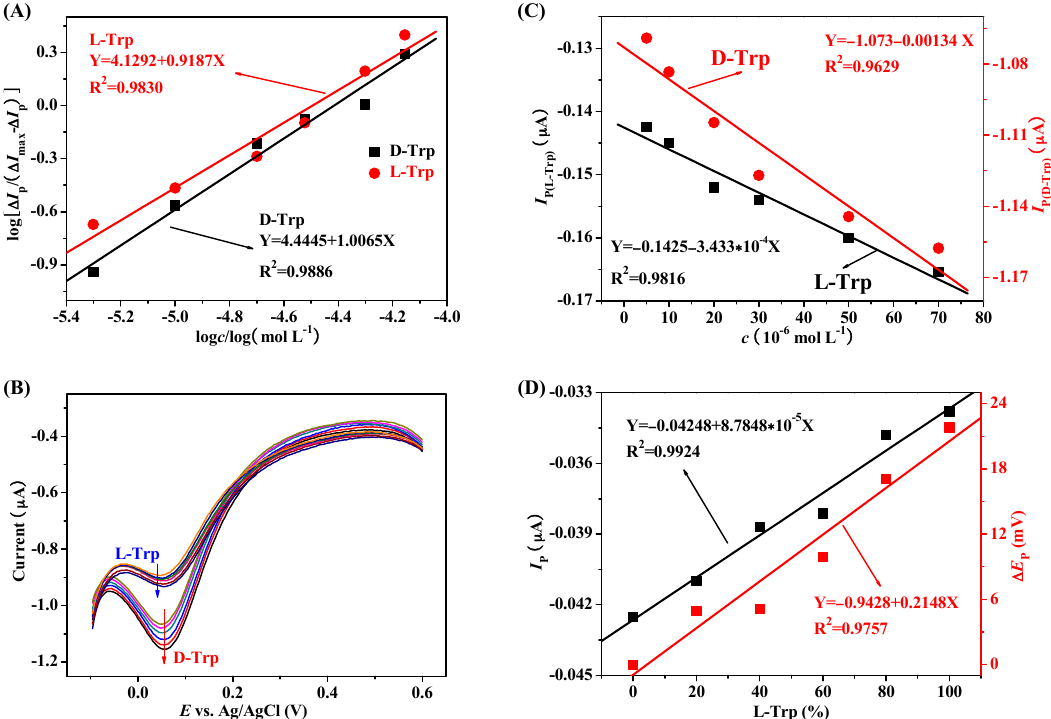
Figure 8. ( A ) Plots of log[ ∆ I p /( ∆ I pmax − ∆ I p )] versus log([ D -Trp]/M) and log([ L -Trp]/M); ( B ) DPVs responses of N-CDs/ β -CD/GCE for L -Trp and D -Trp. The concentrations of Trp enantiomers are 0, 5.0 × 10 − 6 M, 1.0 × 10 − 5 M, 2.0 × 10 − 5 M, 3.0 × 10 − 5 M, 5.0 × 10 − 5 M and 7.0× 10 − 5 M, respectively; ( C ) Plots of I p versus the concentrations of D -Trp (Red line) and L -Trp (Black line); ( D ) Plots of I p (Black line) and ∆ E p (Red line) versus the percentage of L -Trp.